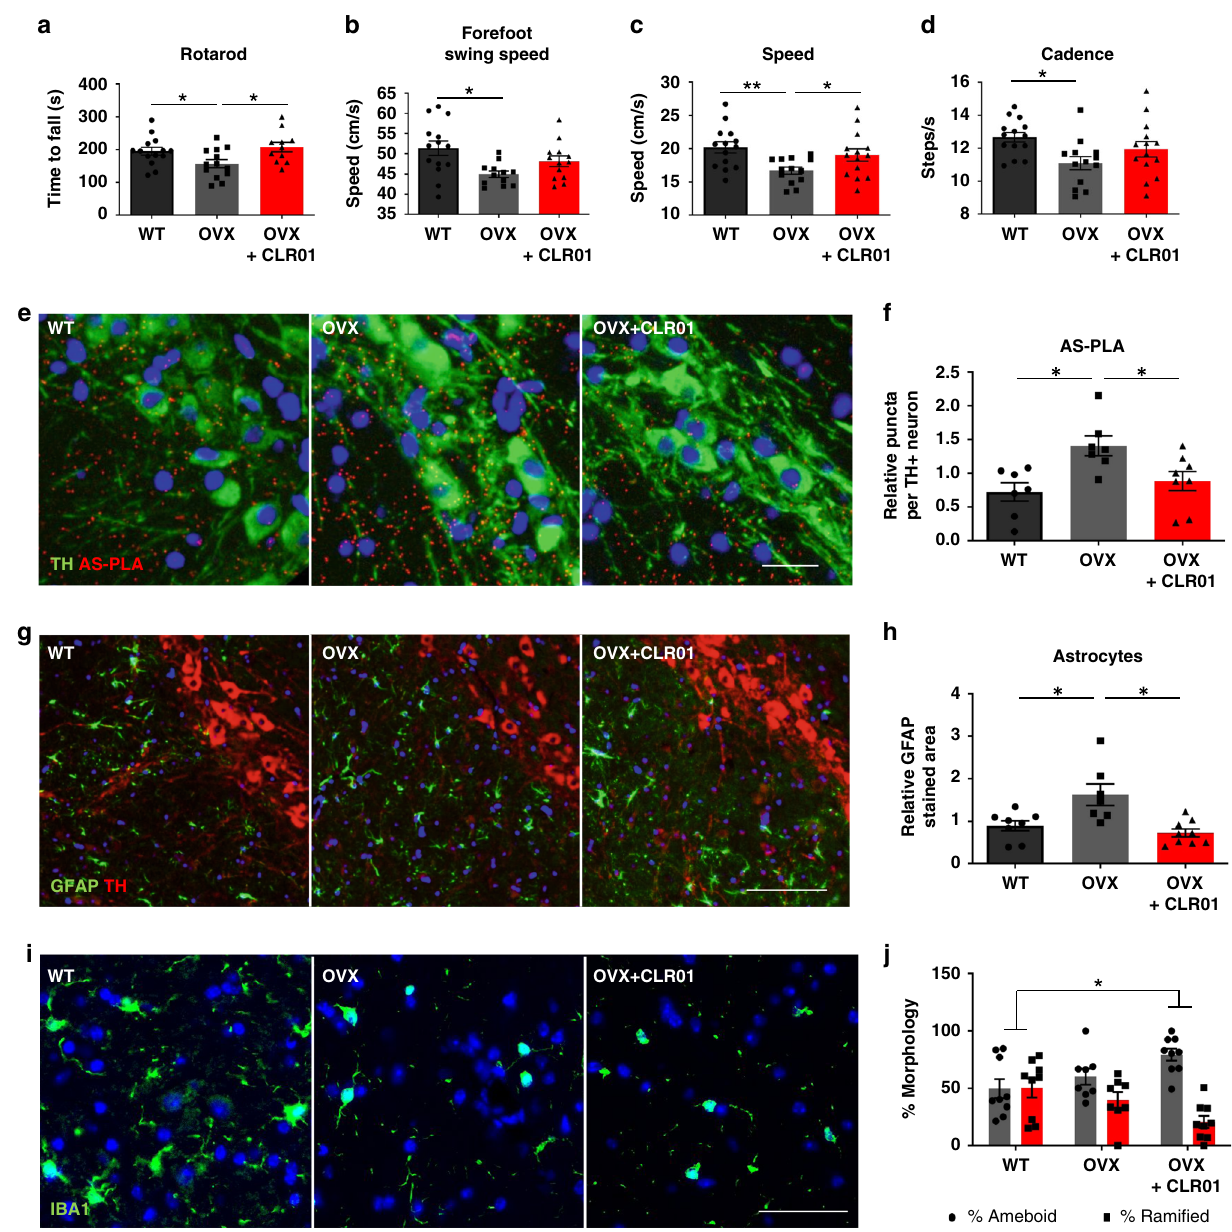
Fig. 4 CLR01 restores motor behavior and reduces early pathology in vivo at 12 months of age. a – d Behavior analysis of rotarod ( a ) and catwalk gait analysis ( b – d ) after 2 months of subcutaneous administration of 40 µ g/kg/day drug or PBS analyzed using a one-way ANOVA (Sidak), n = 11 – 14 animals per group. e , f Representative images and quanti fi cation of AS-PLA puncta per TH + cell. Scale bars = 25 µ m. g – j Representative images and quanti fi cation of GFAP-stained area per fi eld and microglial morphology (expressed as a % from total). Scale bars = 100 and 50 µ m, respectively. a – j were analyzed using one-way ANOVA (Holm – Sidak), e – j n = 8/8. CLR: CLR01 * p < 0.05, ** p < 0.01. a F(2, 35) = 4.138, p = 0.0376, p = 0.0205. b F(2, 37) = 4.000, p = 0.0058. c F(2, 38) = 4.884, p = 0.0078, p = 0.0451. d F(2, 38) = 3.982, p = 0.0151. f F(2, 19) = 6.057, p = 0.0072, p = 0.0338. h F(2, 21) = 8.797, p = 0.0091, p = 0.0012. j F(2, 23) = 4.750, p = 0.0106. For all appropriate panels, data are presented as mean values±